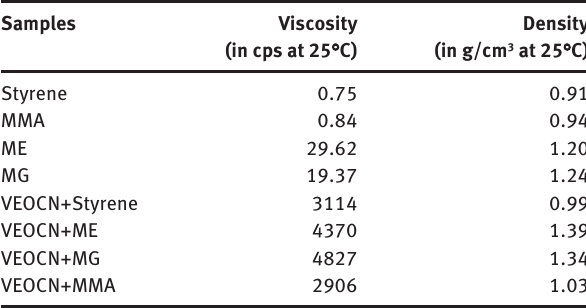
Table 1: The physico-chemical properties of the reactive monomers and the VEOCN resin samples containing these reactive monomers.